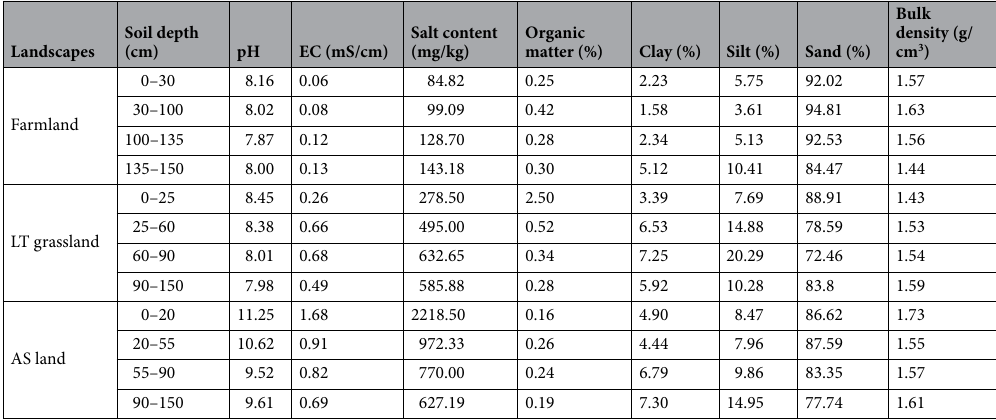
Table 1. The soil physical and chemical properties of farmland, LT grassland and AS land at different depths in study area.